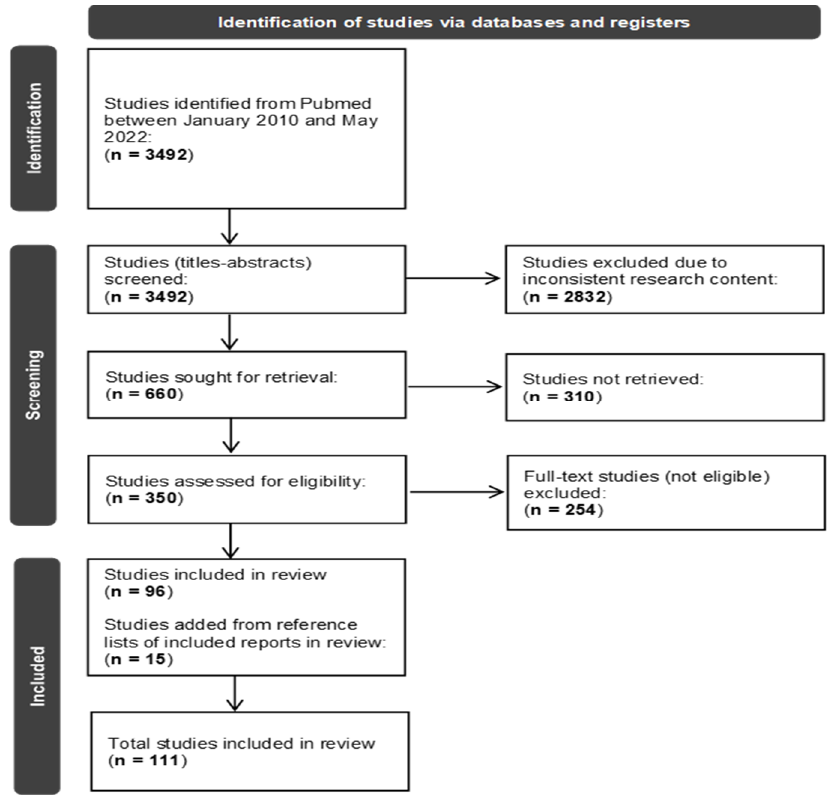
Scheme 1. “PRISMA 2020 flow diagram, depicting the flow of information during the different phases of our systematic review”